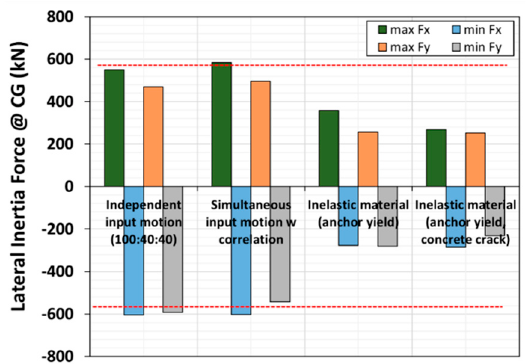
Figure 21. Lateral inertial forces at the center of gravity (M24, dynamic analyses). The lateral displacement is about 12~13 mm (Figure 22).